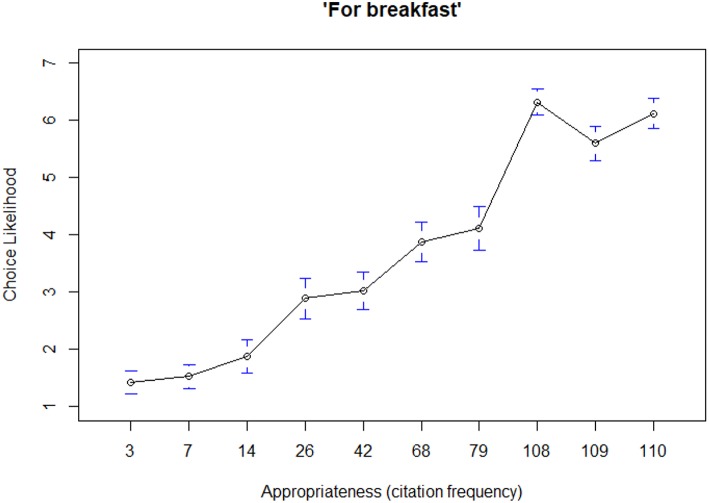
Mean choice likelihood ratings (7-pt scale) by level of product appropriateness for Study 1. Confidence intervals (95% are also shown).